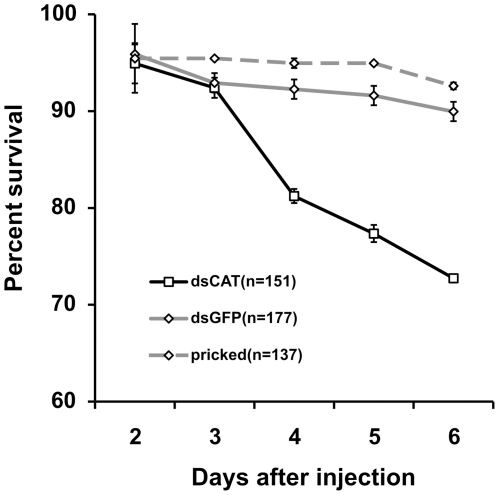
Survival in female Lu. Longipalpis after RNAi-mediated depletion of catalase LlonKat1.Experimental group (dsCAT) exhibits a significantly lower survival rate compared to both dsGFP and pricked control groups, (P<0.0001, Kaplan-Meier, Log Rank χ2 test). Results represent mean ± SEM of 3 independent biological replicates.